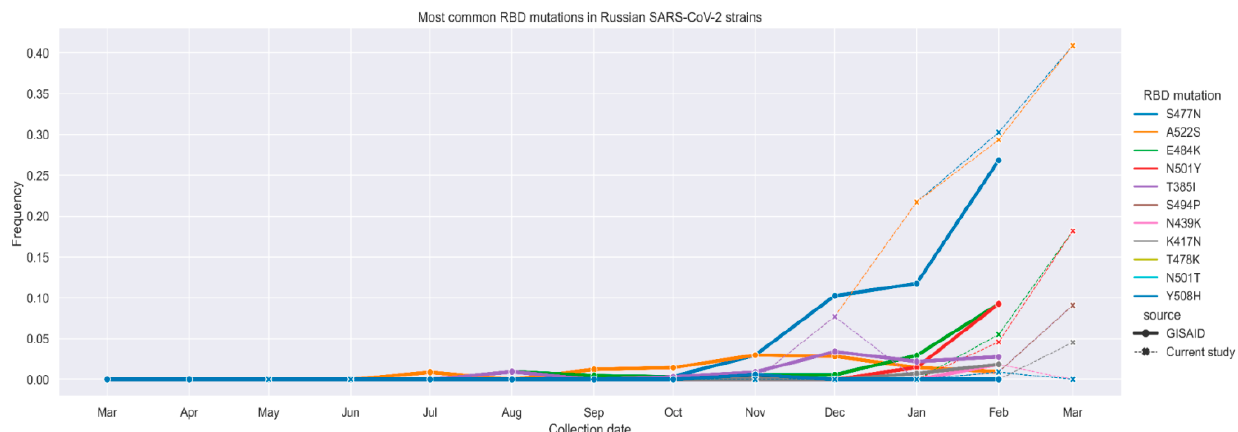
Figure 2. Most common RBD mutations in Russian SARS-CoV-2 variants frequencies of individual mutations according to GISAID data (solid lines) and RBD fragment sequencing data obtained in the current study (dashed lines).